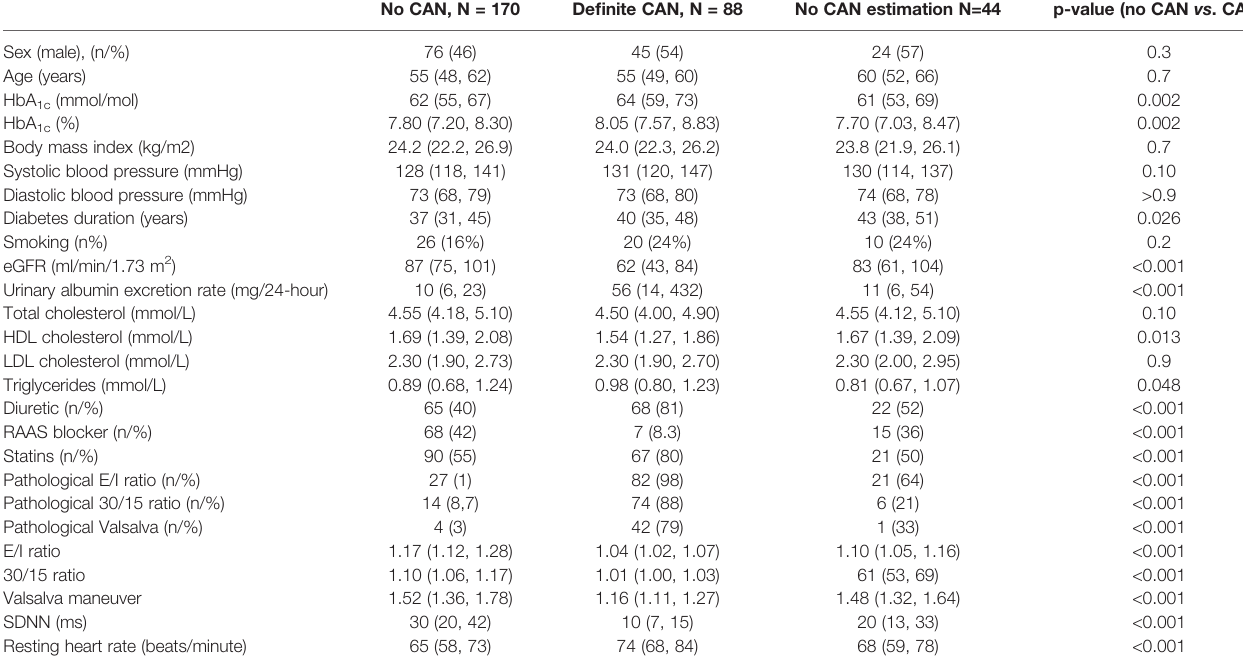
TABLE 1 | Clinical